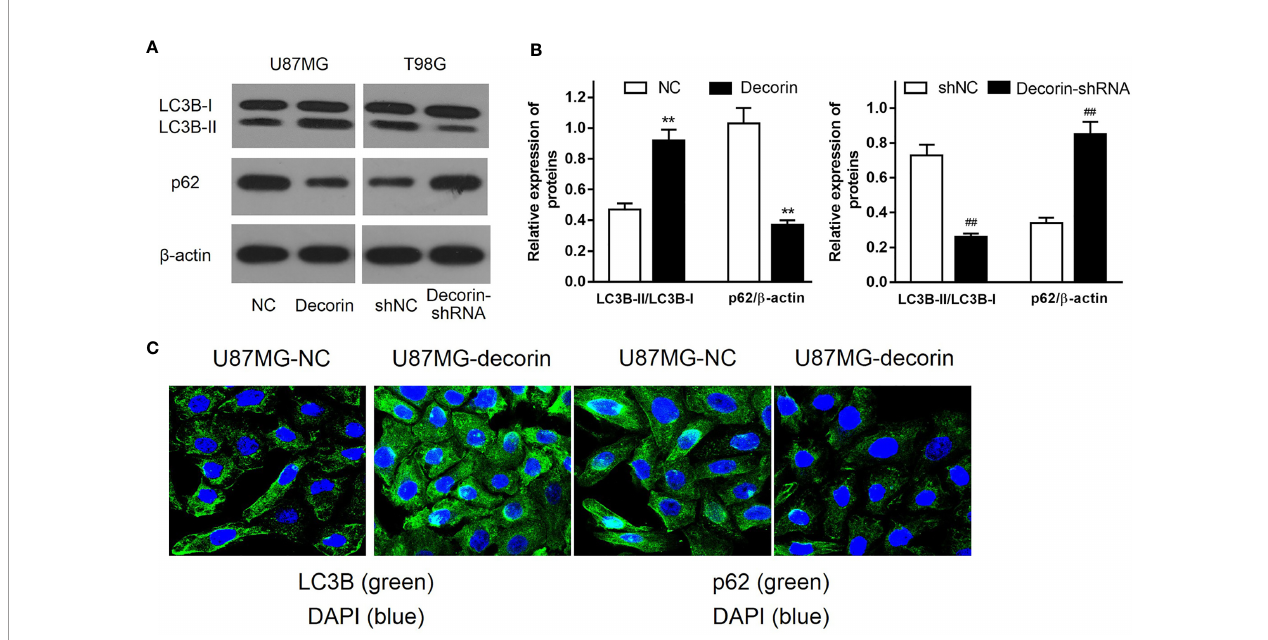
FIGURE 3 | Decorin stimulates autophagy in glioma cell lines. (A) Western blot analysis of autophagy related protein indicated that increased LC3B-I to LC3B-II conversion and reduced expression of p62 were both found in U87MG-decorin cells. Decorin-silencing decreased the ratio of LC3B-II/LC3B-I and elevated the expression of p62 in T98G cells. (B) Measurement data of Western blot results (means ± S.D. @ of 3 independent experiments). **P < 0.01 vs. NC; ## P < 0.01 vs . shNC. (C) Immuno fl uorescence analysis of LC3B and p62 in U87MG cells, in response to overexpression of